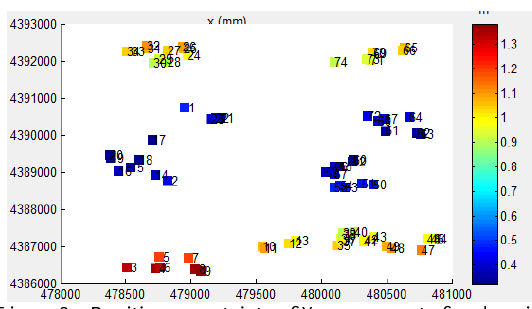
Figure 3.a Position uncertainty of Y component of each point